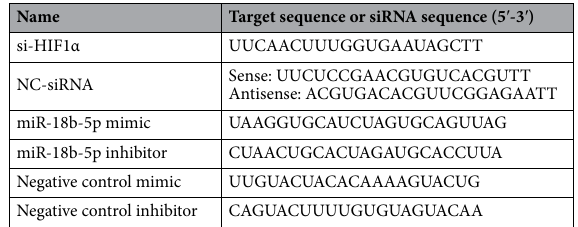
Table 1. Information of the siRNAs and miRNA